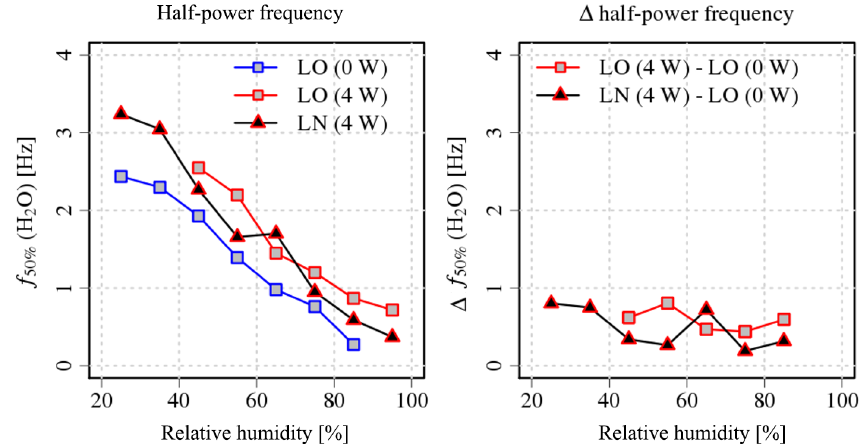
Figure 8. Ensemble half-power frequencies of LI-7200-measured H 2 O number density relative to LI-7500 as a function of ambient relative humidity. Relative humidity classes without ensemble member are omitted. Left panel: field results for the LI-COR old (LO) rain cap without heating of filter and intake tube, as well as the LO and LI-COR new (LN) rain caps for the 4W heater setting. Right panel: differences in half-power frequency between LO and LN rain caps with 4W heating of filter and intake tube, and the LO rain cap without heating of filter and intake tube.